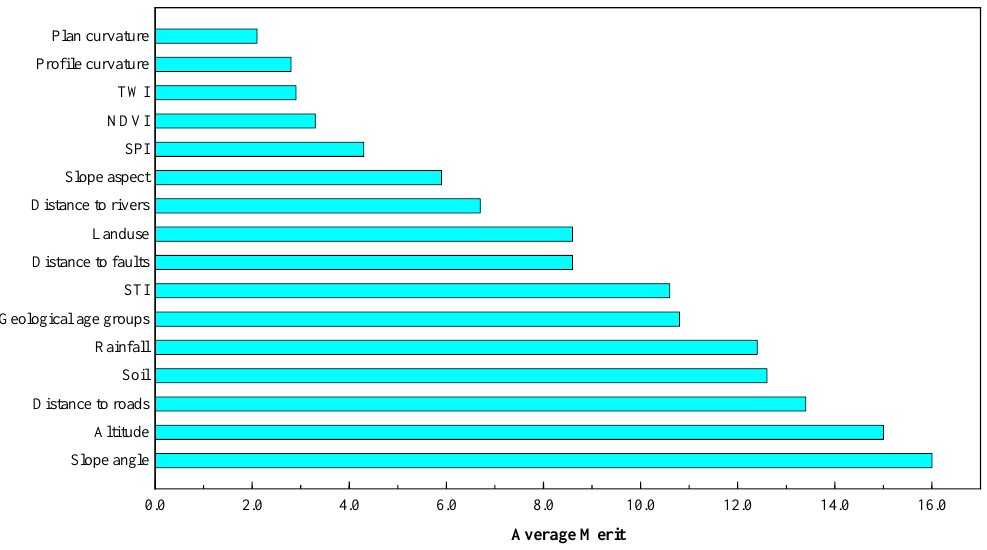
Figure 7. The prediction ability of the landslide conditioning factors.